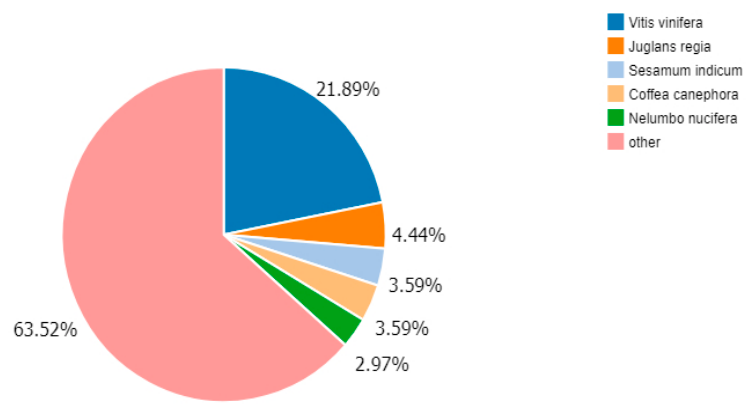
Figure 2. Characteristics of homology search of query sequences aligned by BLASTx to the Nr database. Species distribution of the first BLAST hits for each sequence with a cutoff E-value of 1.0E- 5. 3.2.4. GO Function Classification All the unigene results, previously compared with the NR database, were annotated according to the GO database, with three statistically significant groups identified, namely Biological Process, Cellular Component and Molecular Function (Figure 3). A total of 15